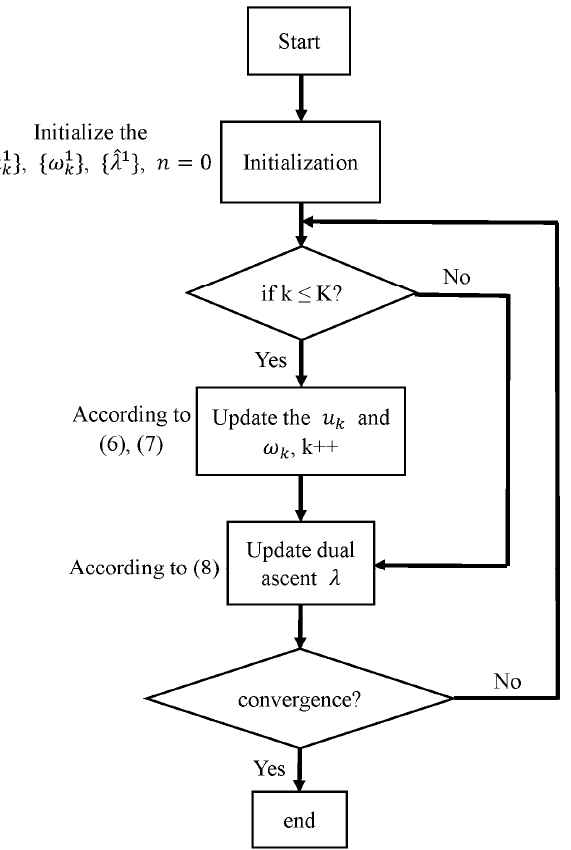
Figure 1. Flow chart of the variational mode decomposition (VMD).